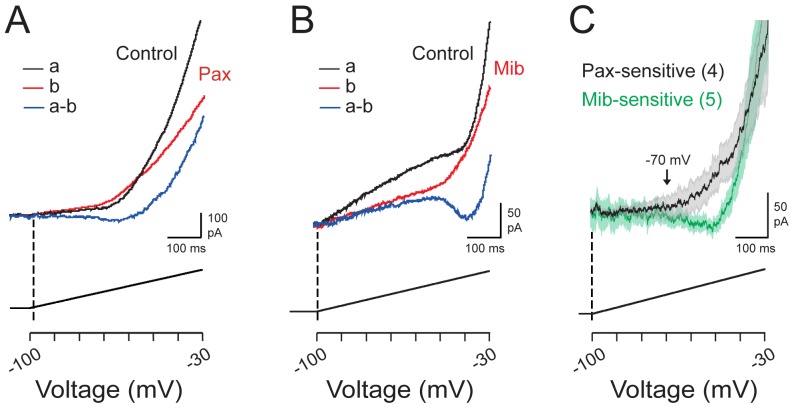
The Cav3-KCa1.1 interaction can activate KCa1.1 in the subthreshold voltage range.Representative whole-cell currents in MVN cells during a ramp command from −100 mV to −30 mV in the presence of 30 µM Cd2+ to block HVA calcium channels. Dashed lines indicate onset of the voltage ramp command. The relative time during the ramp at which different voltages are attained are shown on a voltage scale below. A, Outward current apparent in control recordings (black trace) is reduced by the KCa1.1 channel blocker paxilline (1 µM) (red trace) and isolated below as a difference current (a-b, blue trace). B, Recordings from a separate cell under the same conditions as in (A). Perfusing 1 µM mibefradil (Mib, red trace) blocks both inward and outward currents apparent in control recordings (black trace), with the difference current indicated below (a-b, blue trace). C, Superimposed average records of currents sensitive to paxilline (black trace) or mibefradil (green trace). Current recordings in (C) are average traces with SEM shown by shaded regions. Sample sizes are shown in brackets.